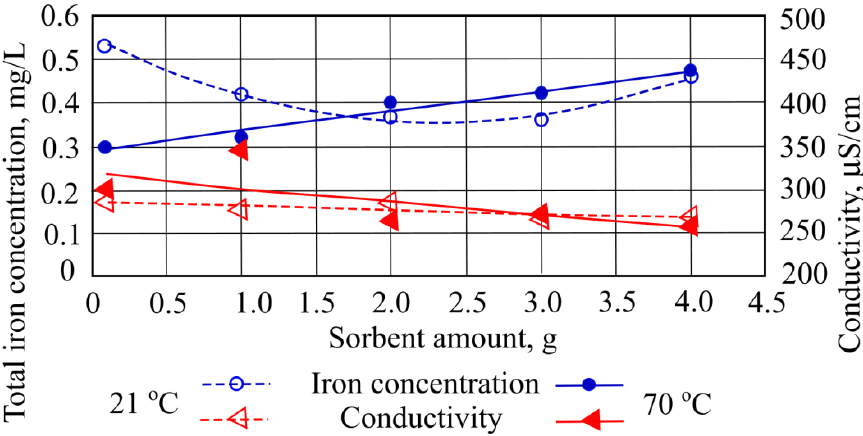
Figure 5. Total iron concentration and conductivity when different quantities of hydrophobic peat sorbent is added to the wastewater.